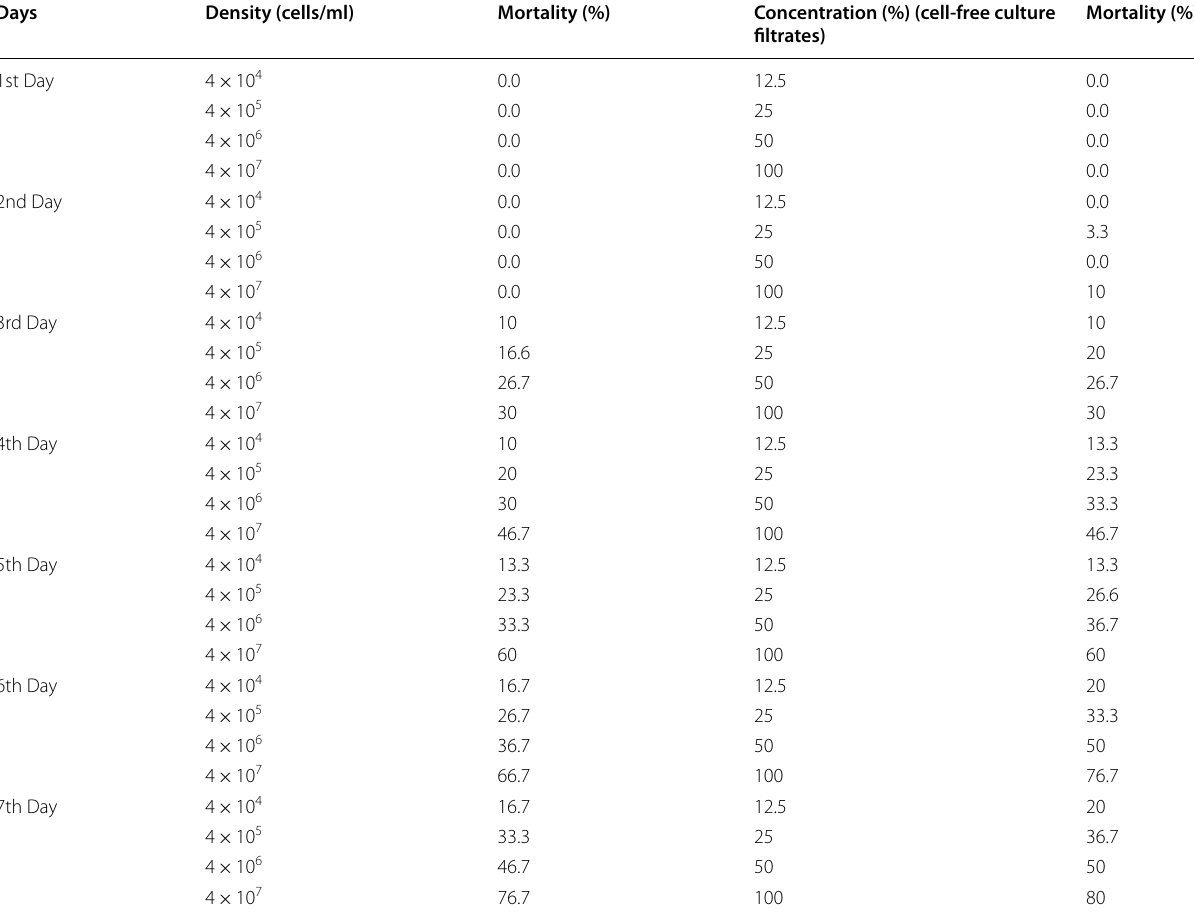
Table 1 Efficacy of bacterial cell suspension and cell-free culture filtrates on Locusta migratoria migratorioides during 7 days